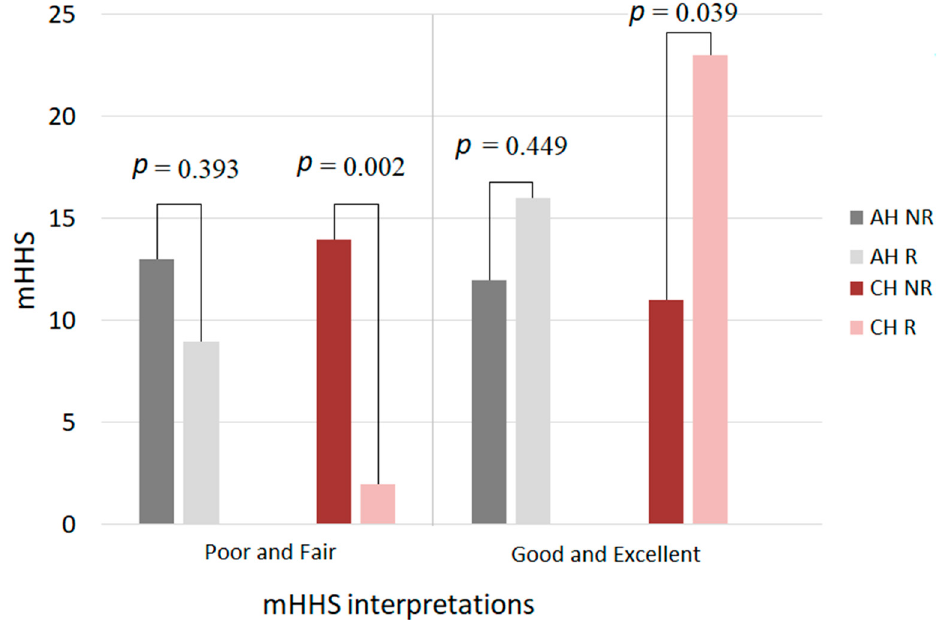
Figure 2. Comparative interpretation of mHHS between the studied groups at the end of the study. Legend: mHHS—modified Harris hip score; group A—group with recovery, group B—group without recovery, AH—arthroplasty hip, CH—contra lateral hip, p values—statistical significance (chi-square test).